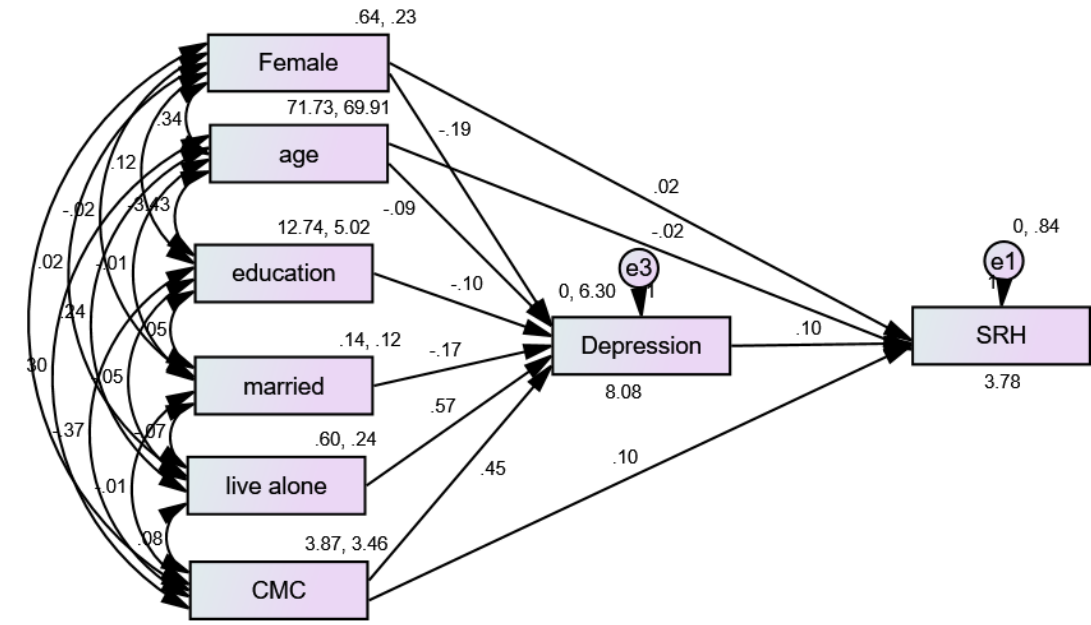
Figure 1. Summary of the Structural Equation Modeling (SEM) overall. Table 3. Summary of the Structural Equation Modeling (SEM) in the pooled sample. Characteristics Estimate